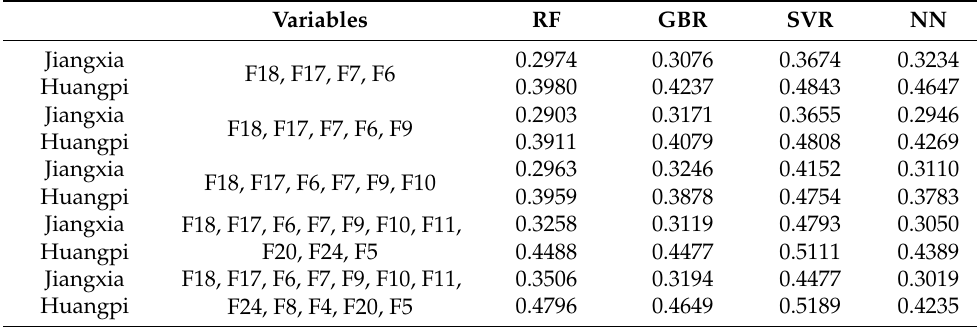
Table 3. Model performance of each machine learning regression of Jiangxia and Huangpi with different numbers of variables. Variables RF GBR SVR NN Jiangxia F18, F17, F7, F6